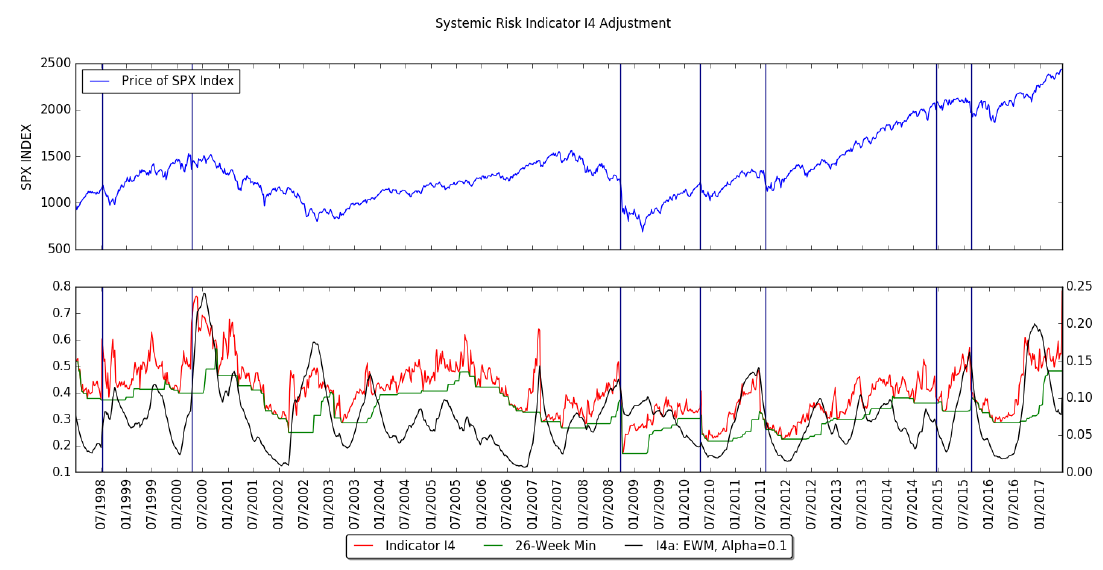
Figure 13. Systemic Risk Indicator I 4 a